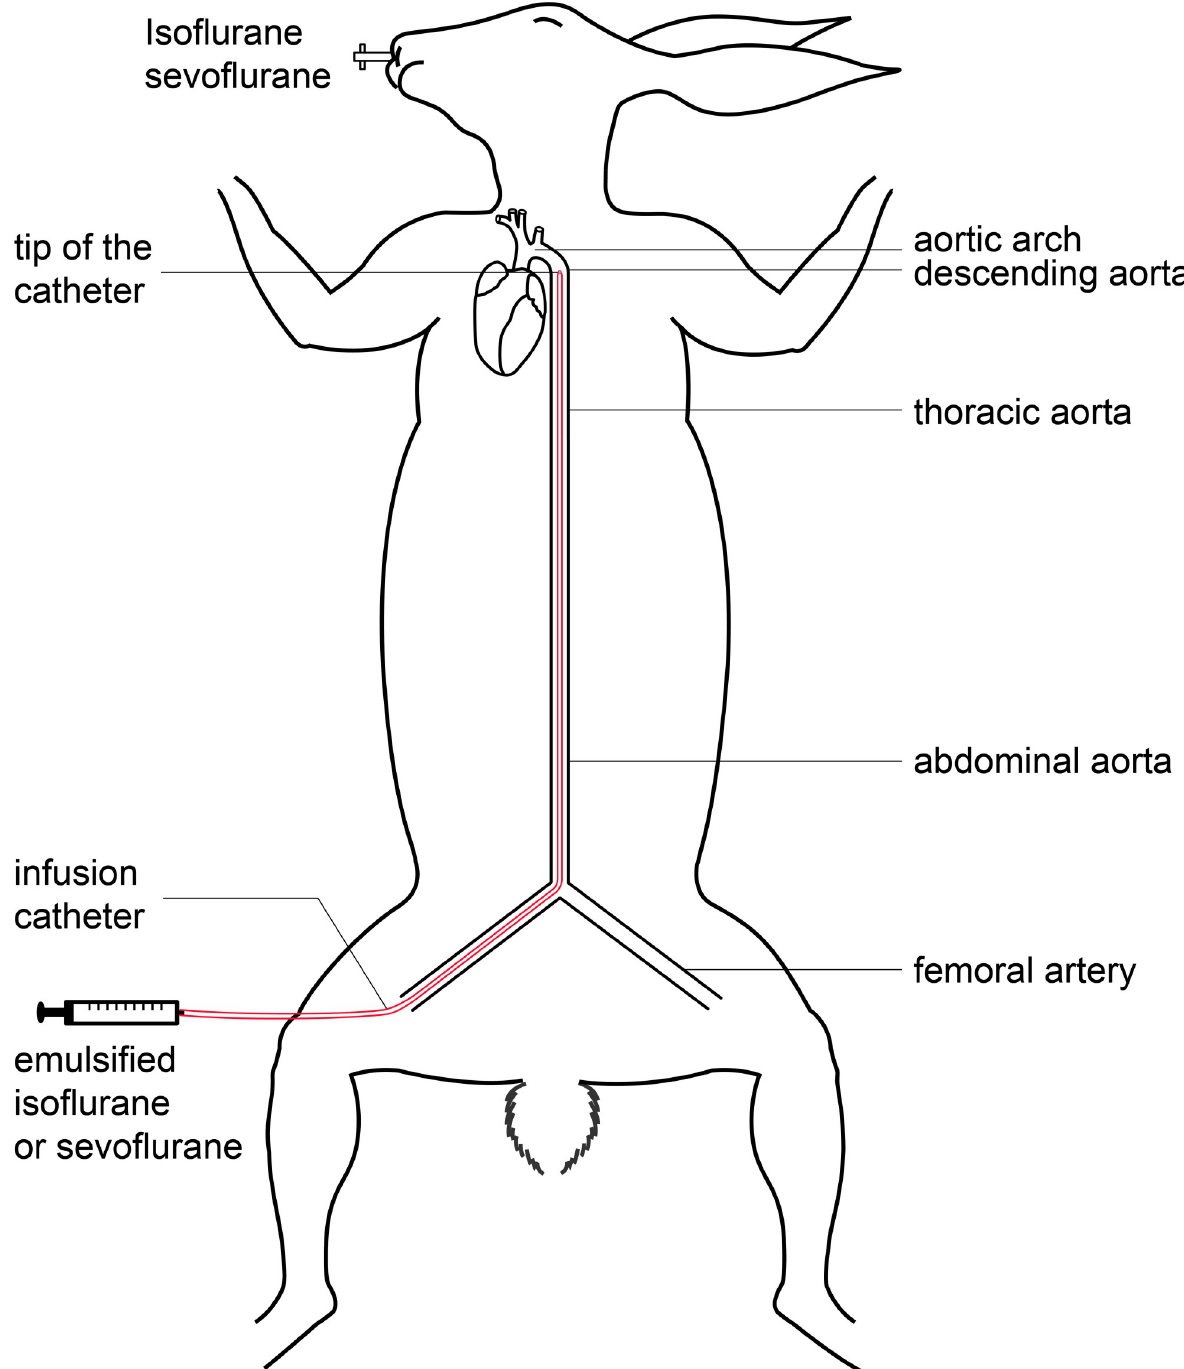
Fig 1. Diagram of the differential anesthetic delivery rabbit